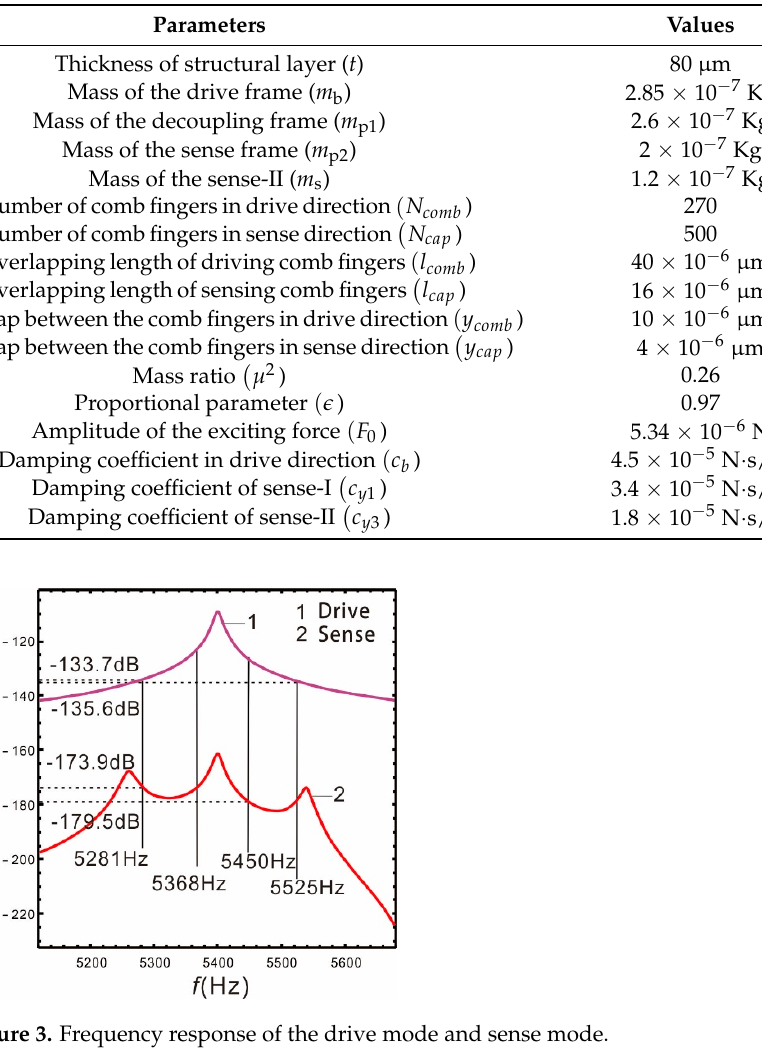
( b ) ( c ) Figure 4. Linear case: the resonant frequency of the drive mode close to the low-order resonant frequency of the sense mode: ( a ) 560 Hz Δ = ; ( b ) 280 Hz Δ = ; ( c ) 230 Hz Δ = . 4. Nonlinear Design and Analysis 4.1. Design of Nonlinear Micro-Beam The force-displacement relationship of a resonator driven by the straight beam is de- scribed as [17]: